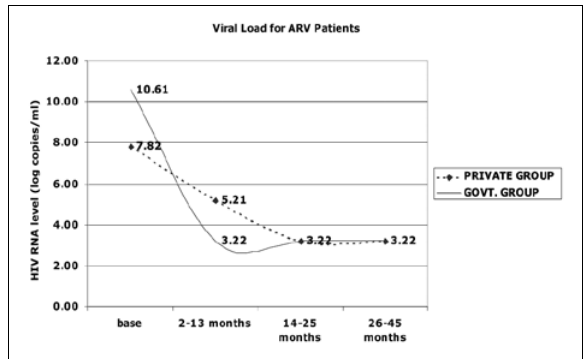
Fig. 5. Comparison of change in viral load (log copies/ml) in the private group versus the government